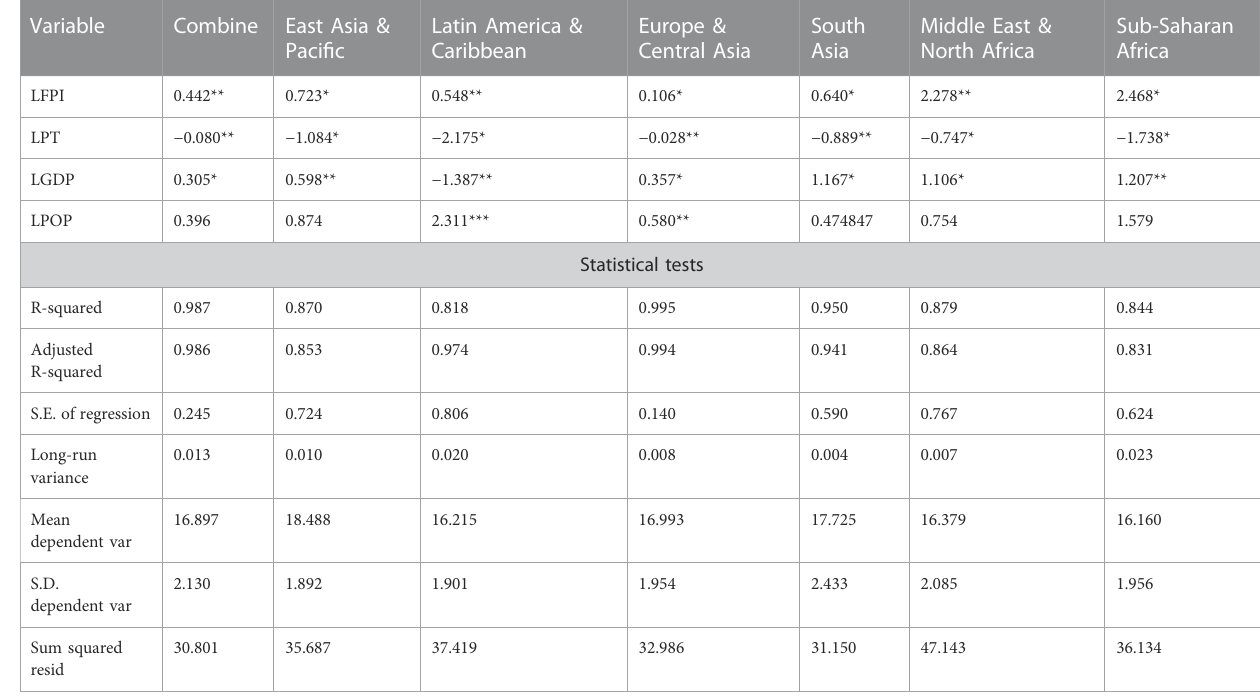
TABLE 7 Estimation results of FMOLS.